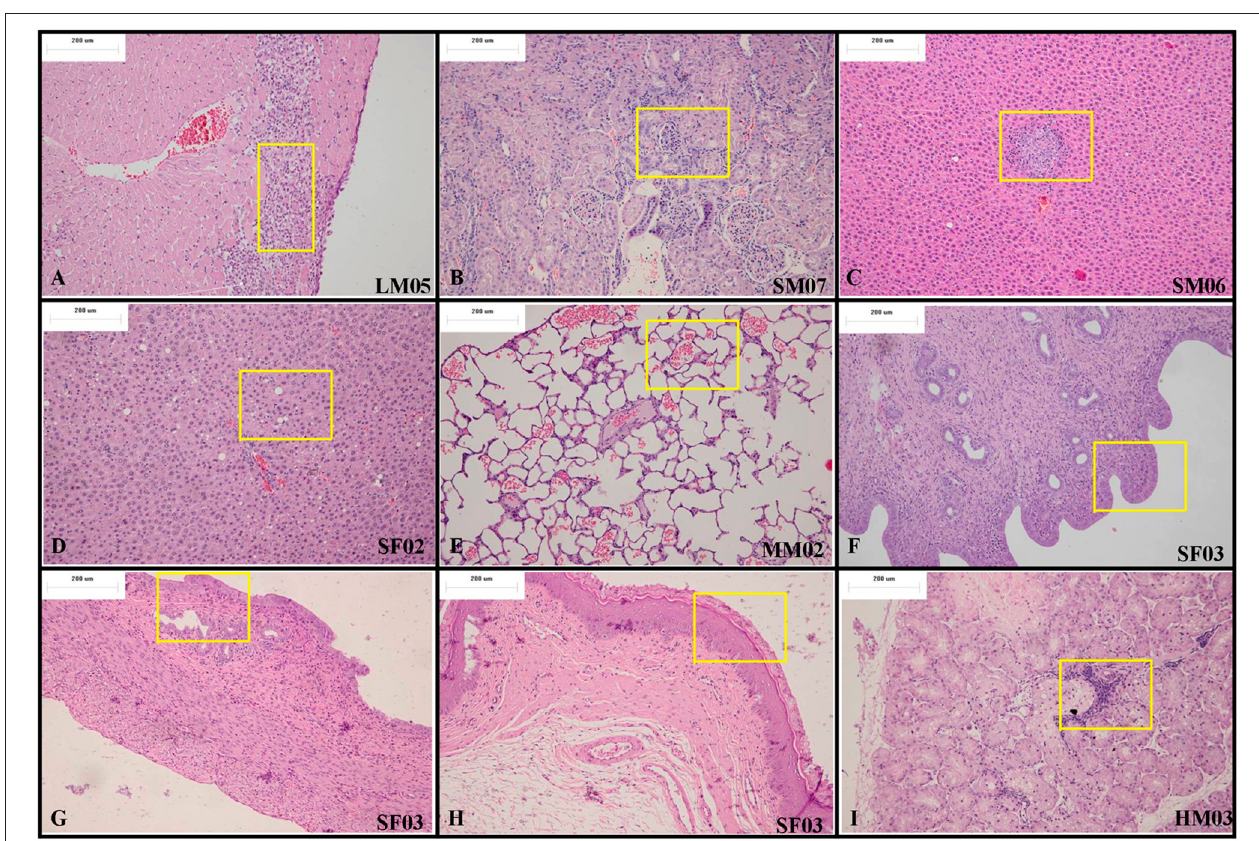
FIGURE 2 | Representative histopathological results of rats at the end of the drug exposure period (Day 28). (A) In the apex of the heart, Arctigenin -12 mg/kg administration resulted in ventricular wall muscle cell interstitial lymphocyte infiltration. (B) In the kidney cortex, renal tubules are basophilic. In the liver, the hepatic lobular structure is complete, but there is partial hepatocyte focal necrosis and interstitial lymphocyte infiltration (C) and cytoplasmic vacuolation and fatty changes (D) . (E) In the lung and primary bronchus, erythrocyte and edema fluid were observed resulting from Arctigenin -36 mg/kg treatment. Changes of proestrus or estrus were observed in the uterus (F) , cervix (G) , and vagina intimal epithelial cells (H) , respectively. (I) Lymphocytic focal infiltration occurred in the prostate mesenchyme. ( × 100